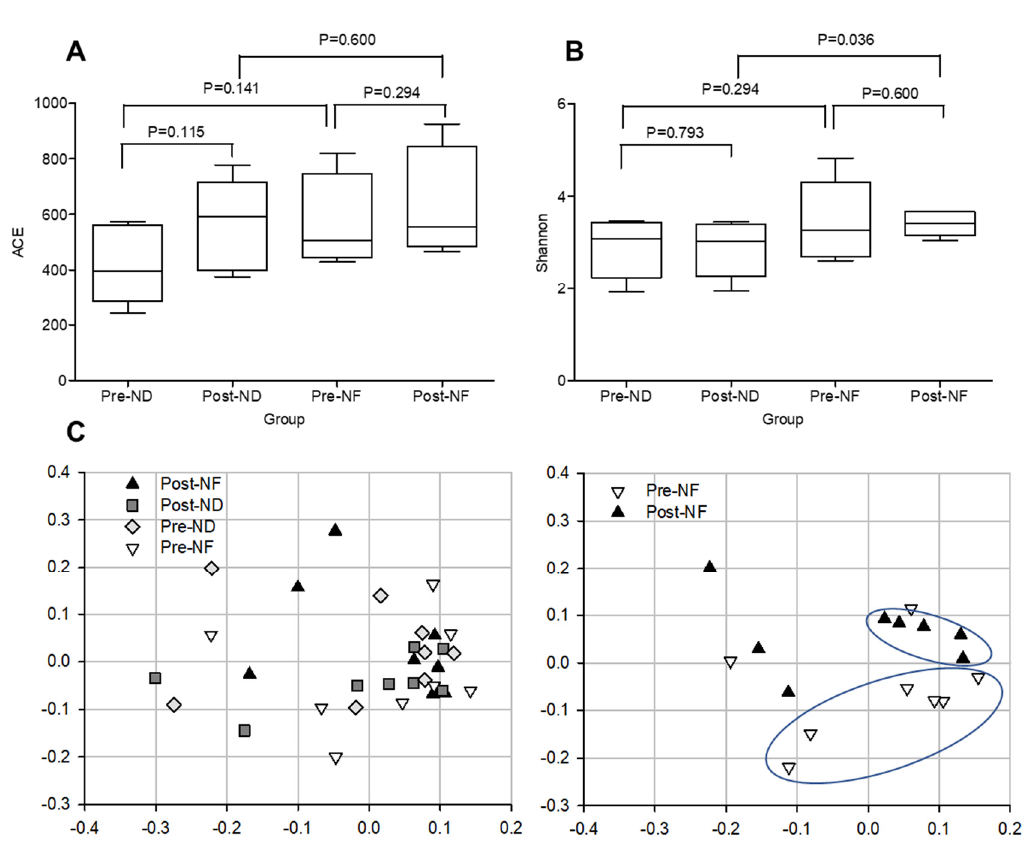
Figure 4. Species richness (ACE index), species diversity (Shannon index), and beta-diversity (PCoA) of species within and between groups. ( A ) Species richness (ACE index), ( B ) species diversity (Shannon index), ( C ) beta-diversity (PCoA). ND (control serum); NF (cosmetic serum containing GOS).